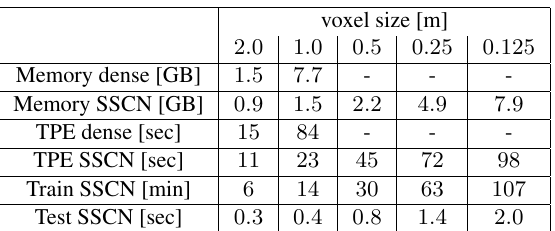
Table 3. Comparing computational parameters between SCCNs and equivalent dense U-Nets for V3D 32 × 32 × 64 m . Shown are GPU memory footprint during the first training epoch, time per epoch (TPE) and training as well as testing times per network. At voxel sizes < 1 m dense networks ran out of